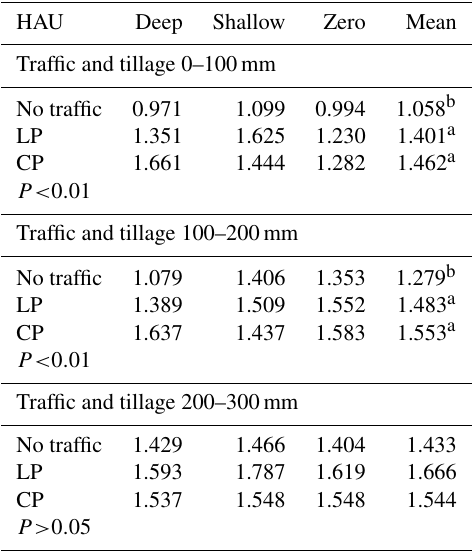
Table 3. Analysis of variance table for penetration resis- tance × traffic, tillage, and tillage × traffic interactions between 0 and 150, 150 and 300, and 300 and 450mm.